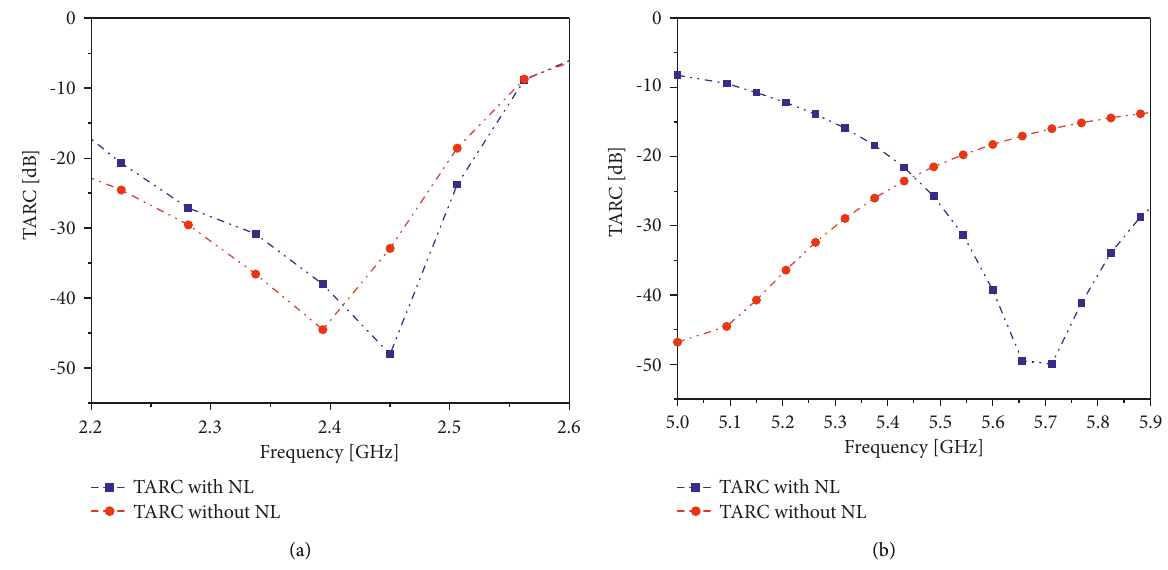
Figure 18: The TARC of antenna#2 with and without NL: (a) 2.4 GHz and (b) 5.8GHz.